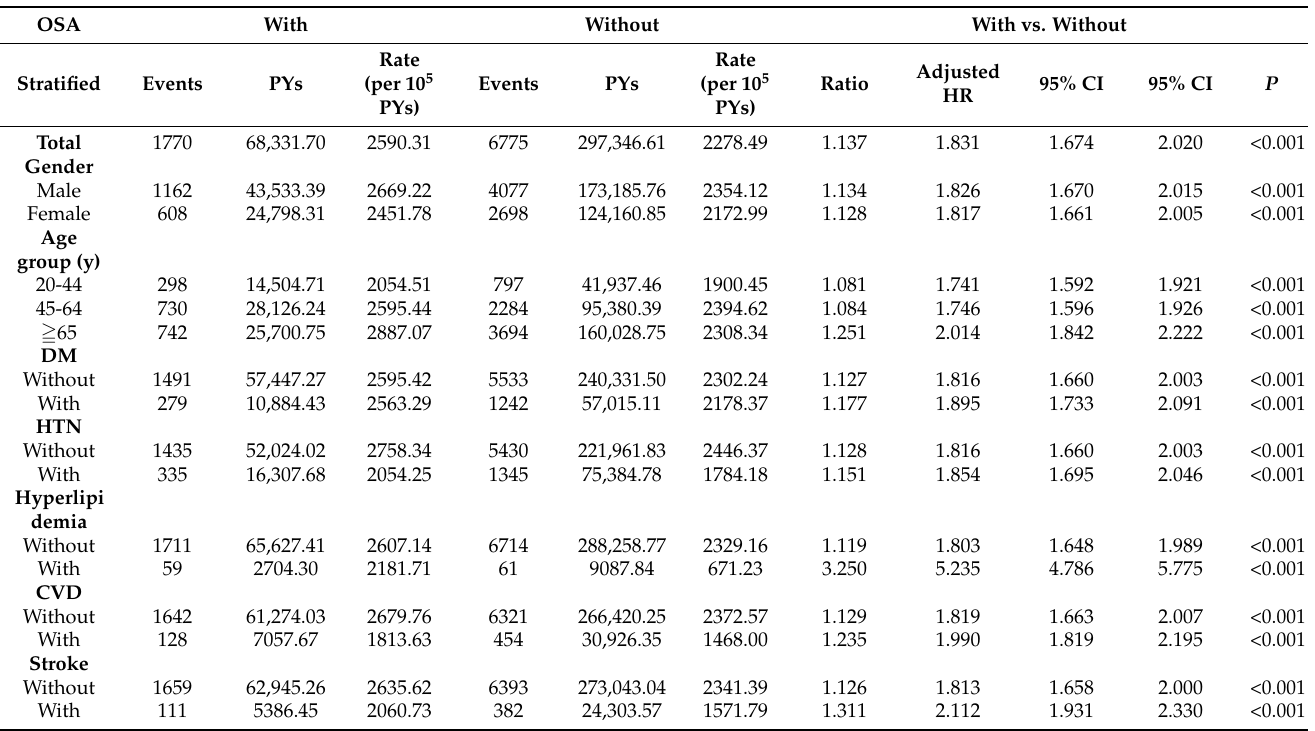
Table 2. Injury factors stratified by variables by using Cox